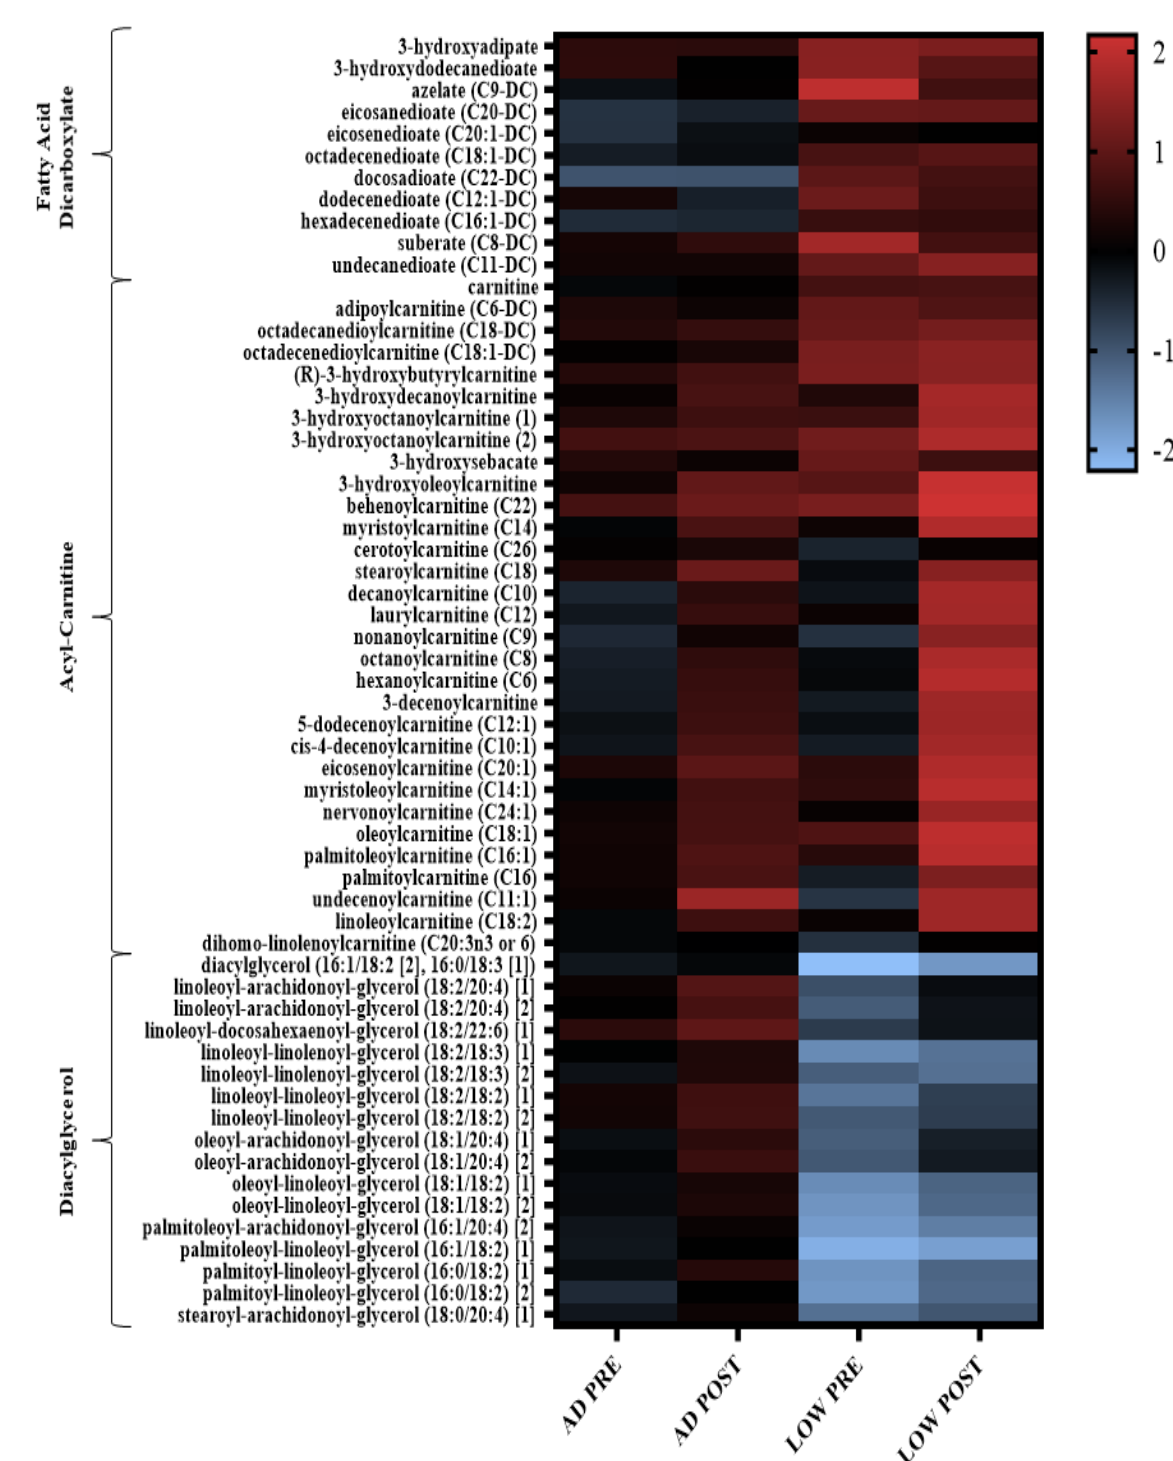
Figure 2. Heatmap of the change in diglycerol, acyl-carnitine, and fatty acid dicarboxylate metabolites that had a significant main effect of treatment (LOW compared to AD) or time-by-treatment interactions; n = 11, p < 0.05, Q < 0.10. Mean ± SD data with p and Q values reported in Supplemental Table S1.